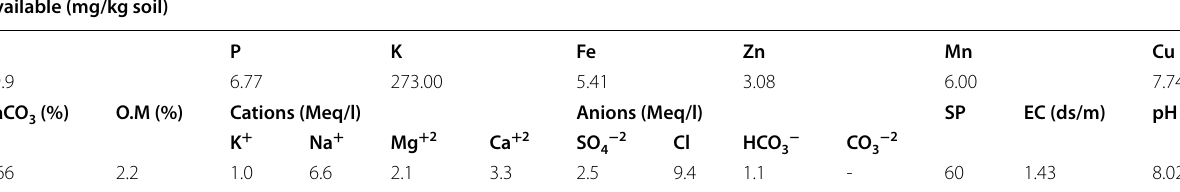
Table 1 Physical and chemical properties of the experimental soil Available (mg/kg